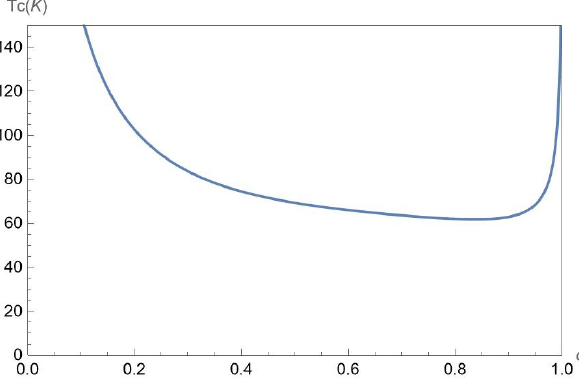
Figure 11. The mean-field phase transition critical temperature T c ( n A , n B , α , ∆ , D ) versus the param- eter α for chosen gap ∆ = 0.5 ¯ hv F / a , interlayer separations D = 25 nm at the fixed concentrations n A = 50 × 10 11 cm − 2 and n B = 50 × 10 11 cm − 2 of A and B excitons, respectively.